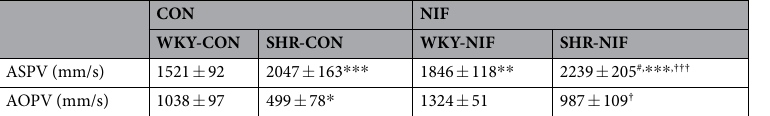
Table 2. General features of the flow velocity in the aortas of experimental rats. Values are presented as the mean ± SD. (n = 6). * P < 0.05, ** P < 0.01, *** P < 0.001, vs WKY-CON. # P < 0.05, vs SHR-CON. † P < 0.05, ††† P < 0.001, vs WKY-NIF. ASPV, ascending aorta peak velocity; AOPV, aortic arch peak velocity; CON, control; NIF,